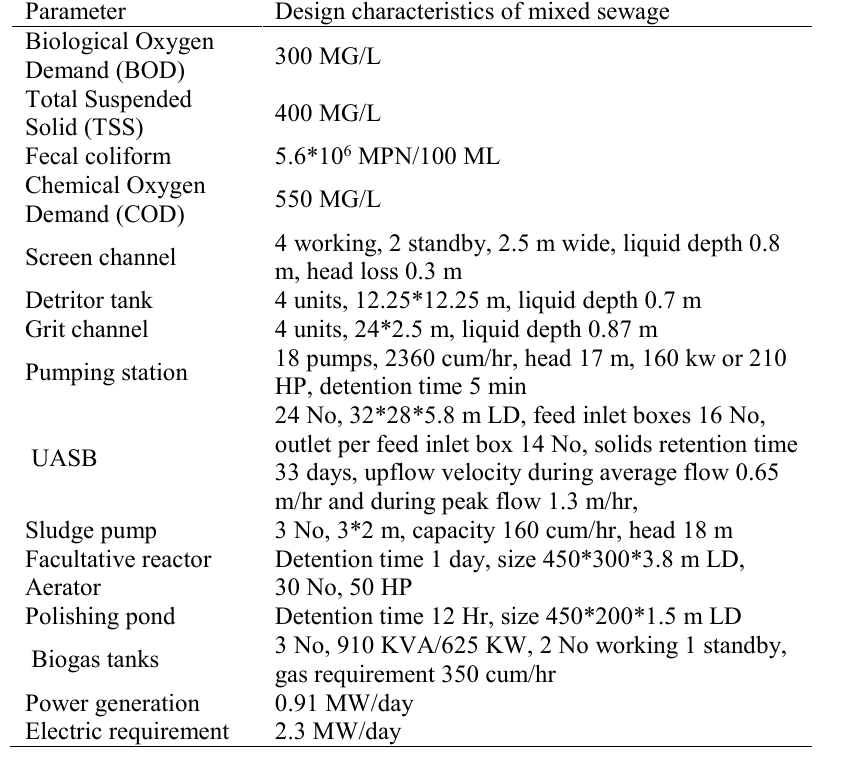
Table 6. Existing characteristics of WWTP in Hyderabad, India (This study)